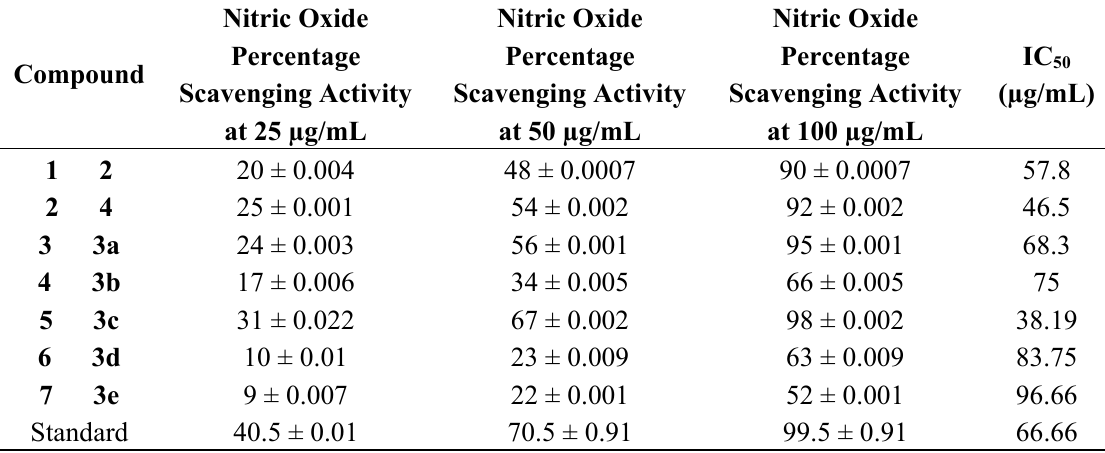
Table 3. Antioxidant activity of synthesized compounds by nitric oxide scavenging activity.